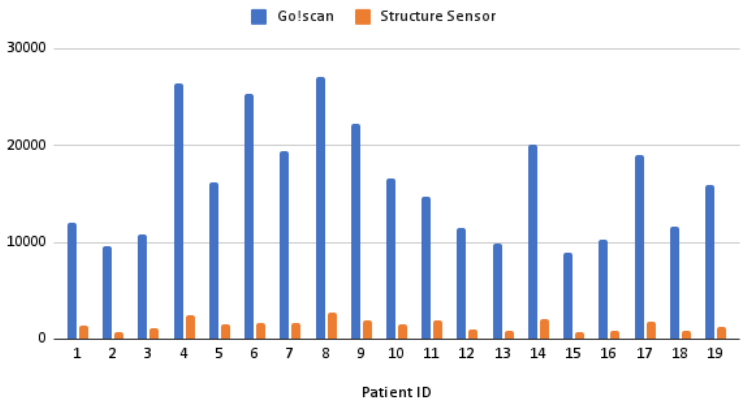
Figure 18. Bar plot of the number of vertices in the cropped surfaces acquired using the two